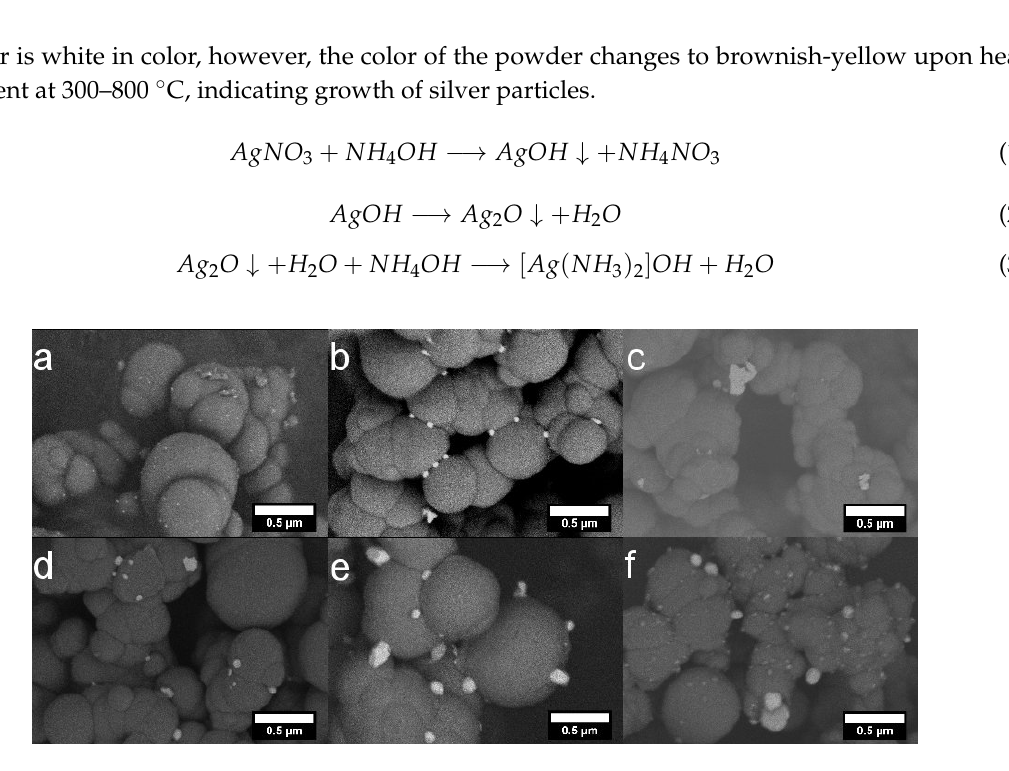
Figure 1. scanning electron microscopy (SEM) images of SiO 2 -Ag powders heat treated at ( a ) 300 ◦ C; ( b ) 400 ◦ C; ( c ) 500 ◦ C; ( d ) 600 ◦ C; ( e ) 700 ◦ C and ( f ) 800 ◦ C for 75 min. All scale bars are 0.5 µ